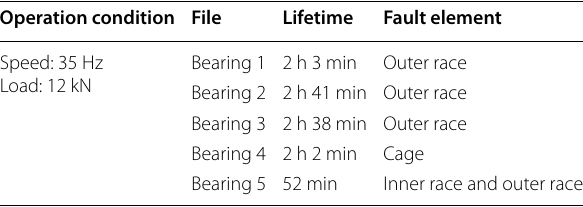
Table 1 Detailed description of XJTU-SY datasets Operation condition File Lifetime